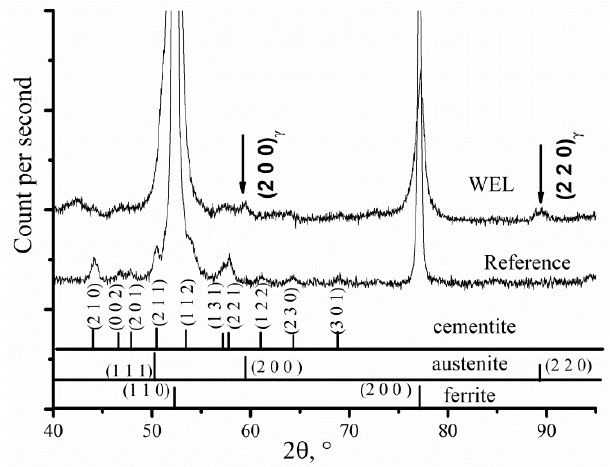
Figure 2. XRD spectra of the WEL zone at the rail surface and the reference pearlitic specimen from the rail center